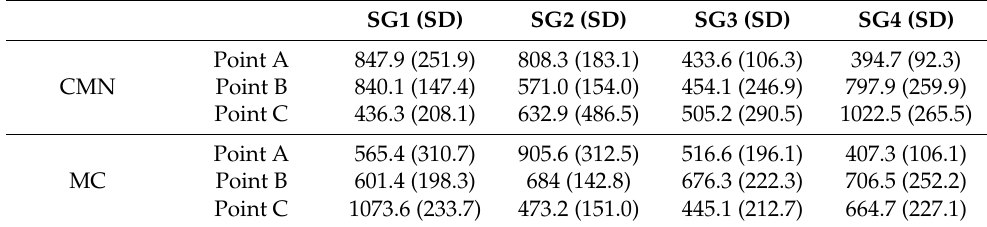
Table 2. Microstrains ( µε / µε ) and standard deviation (SD) according to the load application point. SG1